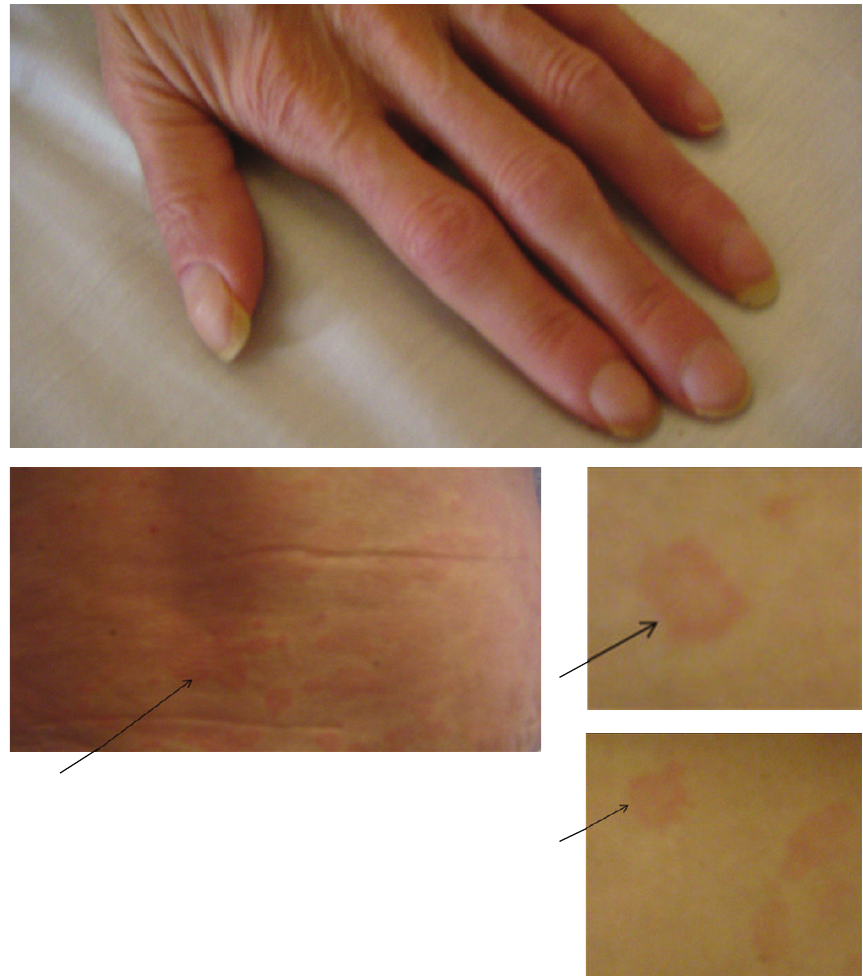
Figure 1: Urticaria as seen on the skin of the back, thigh, and arm of patient (from left to right).